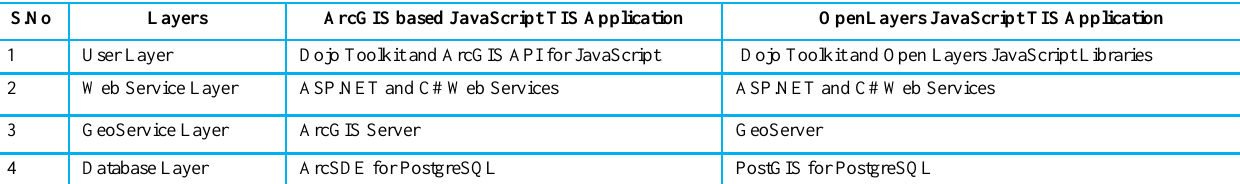
Table 1 : Technologies used for developing commercial and open source TIS